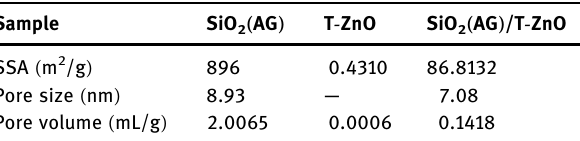
Table 1: SSA, pore size, and pore volume of SiO 2 ( AG ) , T - ZnO, and SiO 2 ( AG ) /T - ZnO